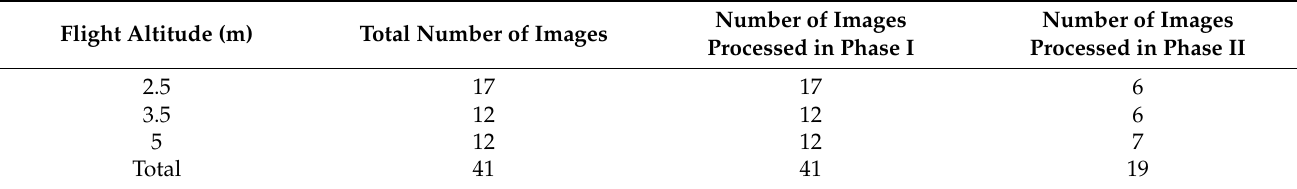
Table 2. Frequency of images captured at each phase.